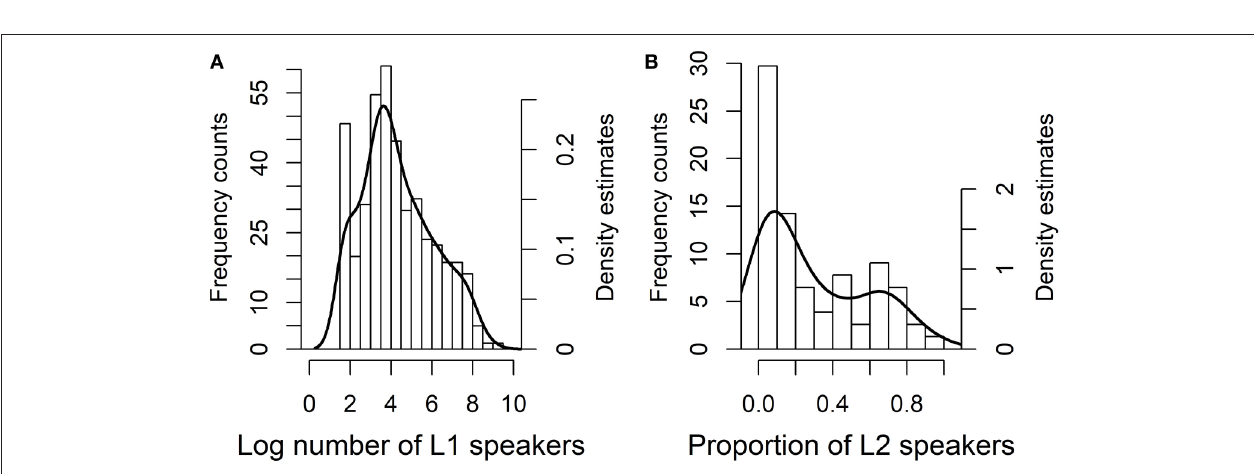
FIGURE 11 | Frequency histograms and superimposed density estimates for the independent demographic variables in case study 2, for log number of native speakers on the left (A) and for the proportion of L2 speakers (including semi-speakers) on the right (B)